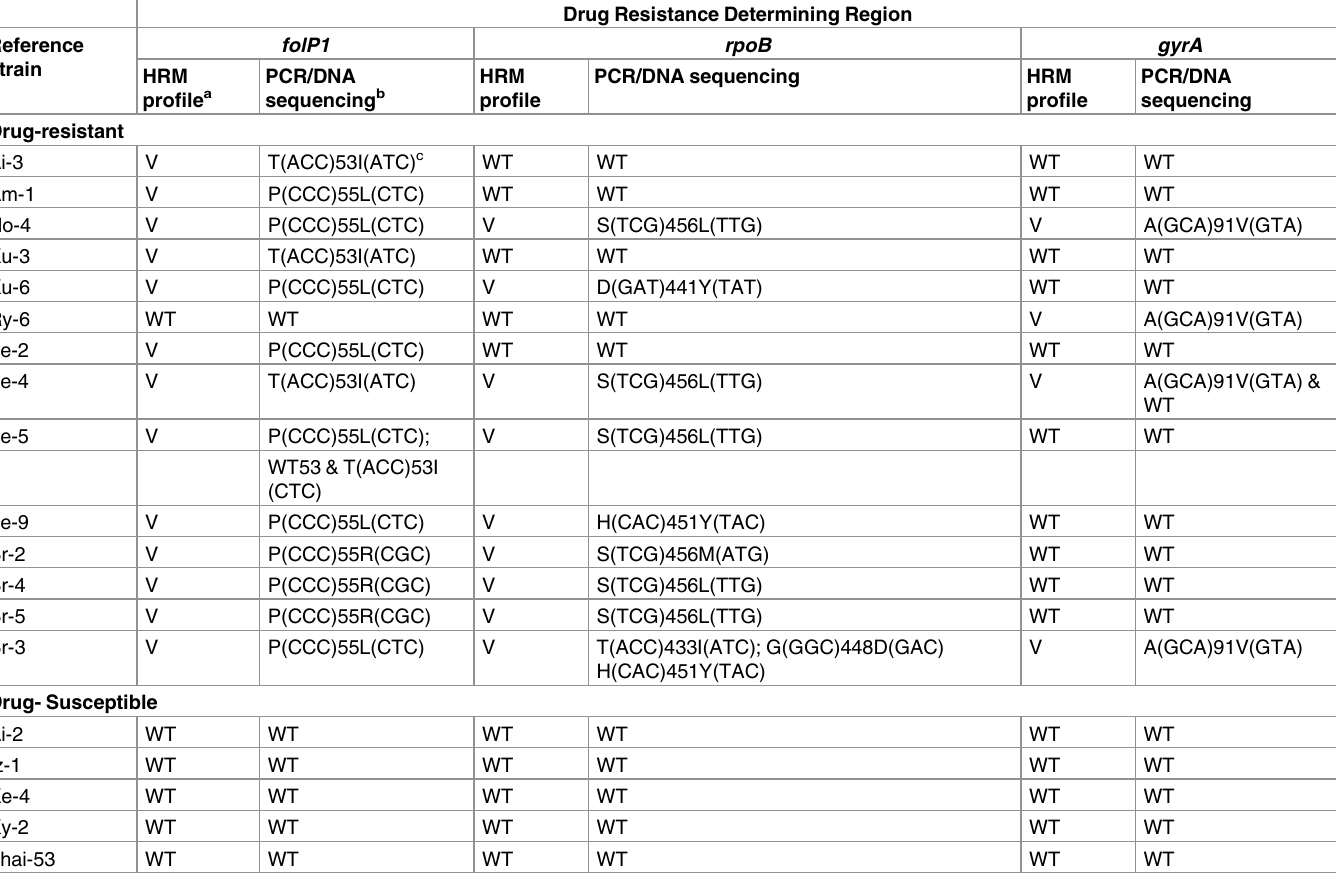
Table 2. qPCR/High Resolution Melt (HRM) drug susceptibility testing (DST) of M . leprae referencestrains. Drug Resistance Determining